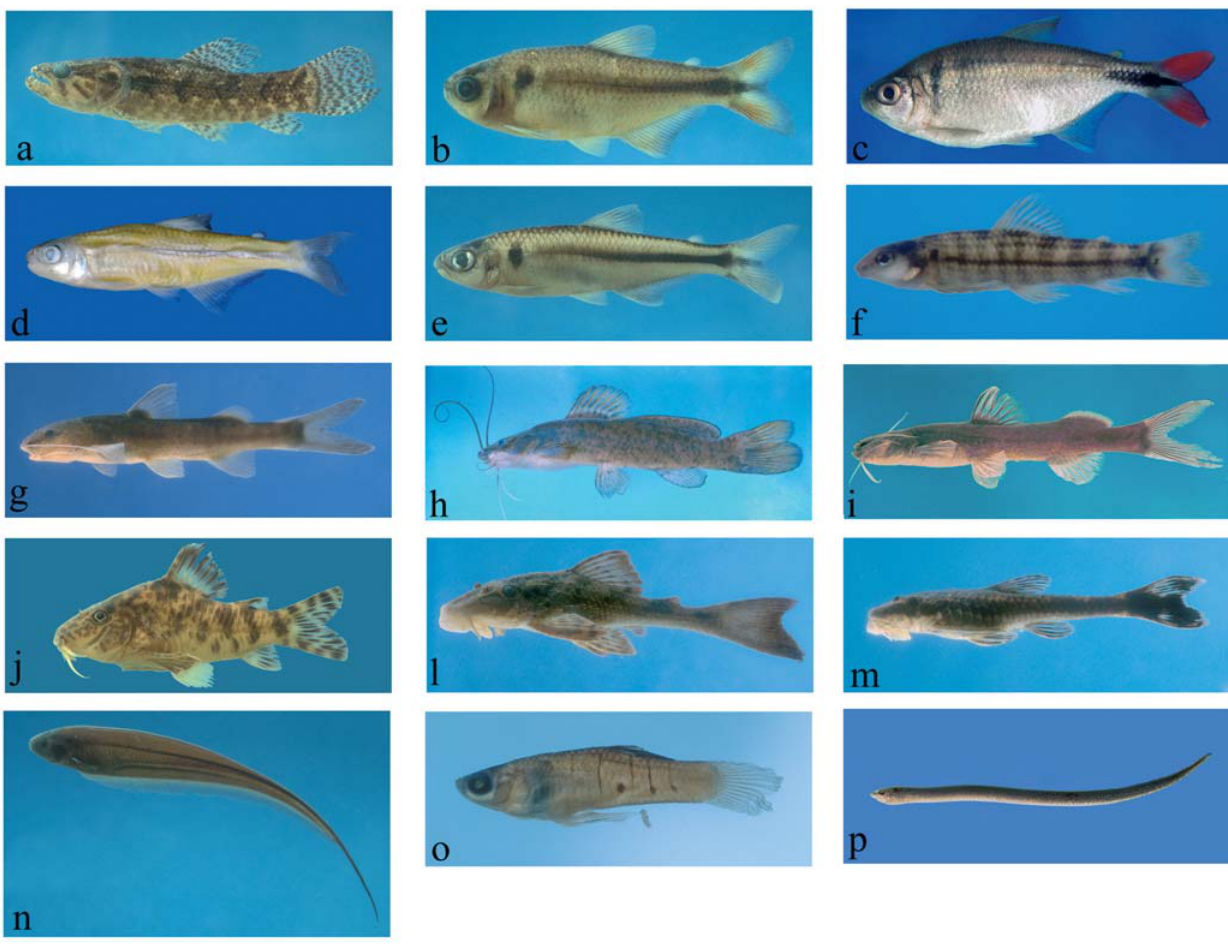
Fig. 3. Representative specimens of the collected species: a) H . malabaricus (LIRP 3077; 101.8 mm SL); b) A . paranae (LIRP 3093; 47.4 mm SL); c) A . fasciatus (LIRP 3161; 48.3 mm SL); d) B . stramineus (LIRP 3157; 45.3 mm SL); e) P . argentea (LIRP 3121; 55.2 mm SL); f) C . gomesi (LIRP 3138; 32.1 mm SL); g) C . iheringi (LIRP 3127; 36.0 mm SL); h) R . quelen (LIRP 3151; 88.9 mm SL); i) P . tenebrosa (LIRP 3160; 37.3 mm SL); j) C . difluviatilis (LIRP 3056; 44.0 mm SL); l) H . ancistroides (LIRP 3122; 37.4 mm SL); m) Hisonotus sp. (LIRP 3092; 30.4 mm SL); n) E . virescens (LIRP 3080; 119.8 mm SL); o) P . jucundus (LIRP 3063; 19.8